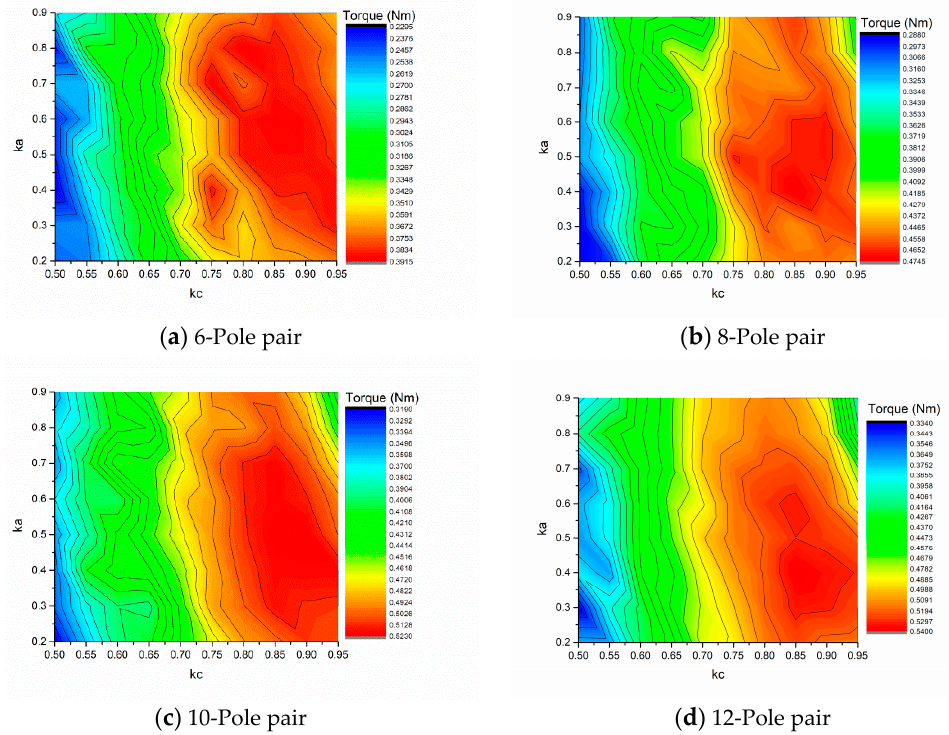
Figure 6. Torque of CPM with the variation of the ratio of the pole pitch and the ratio of the claw pole short edge to long